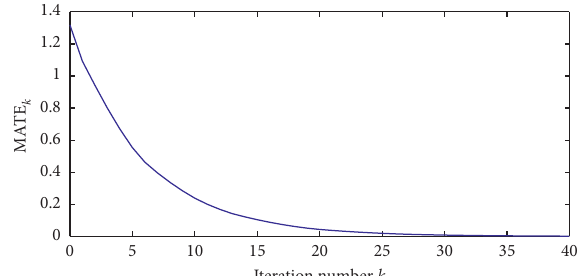
Figure 5: Reference surface y